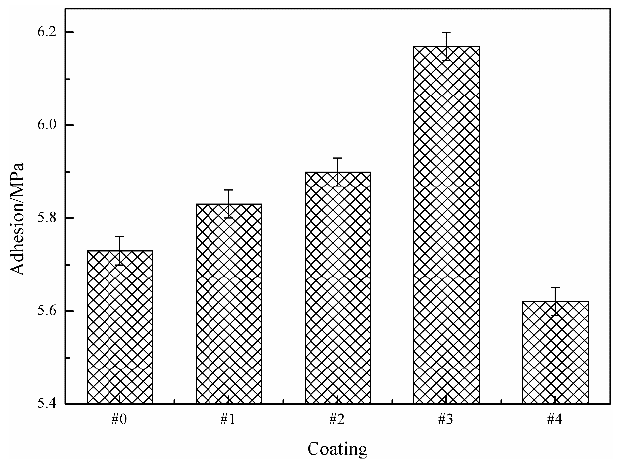
Figure 4. Adhesive property of different WPU SCCs with modified fillers.